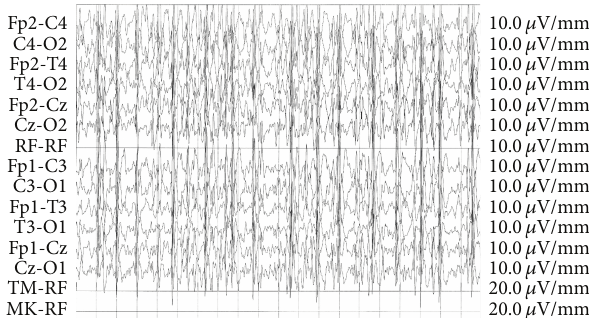
Figure 2: EEG showed a generalized slow activity with high amplitude. Spikes and spikes-slow waves complex appear singly or in group and are unilateral or bilateral. When bilateral, they can occur synchronously or independently. The parameters used for EEG registration are sens: 10 microV/mm, TC: 0,10 s, and HF: 15,0 Hz. The montage is longitudinal